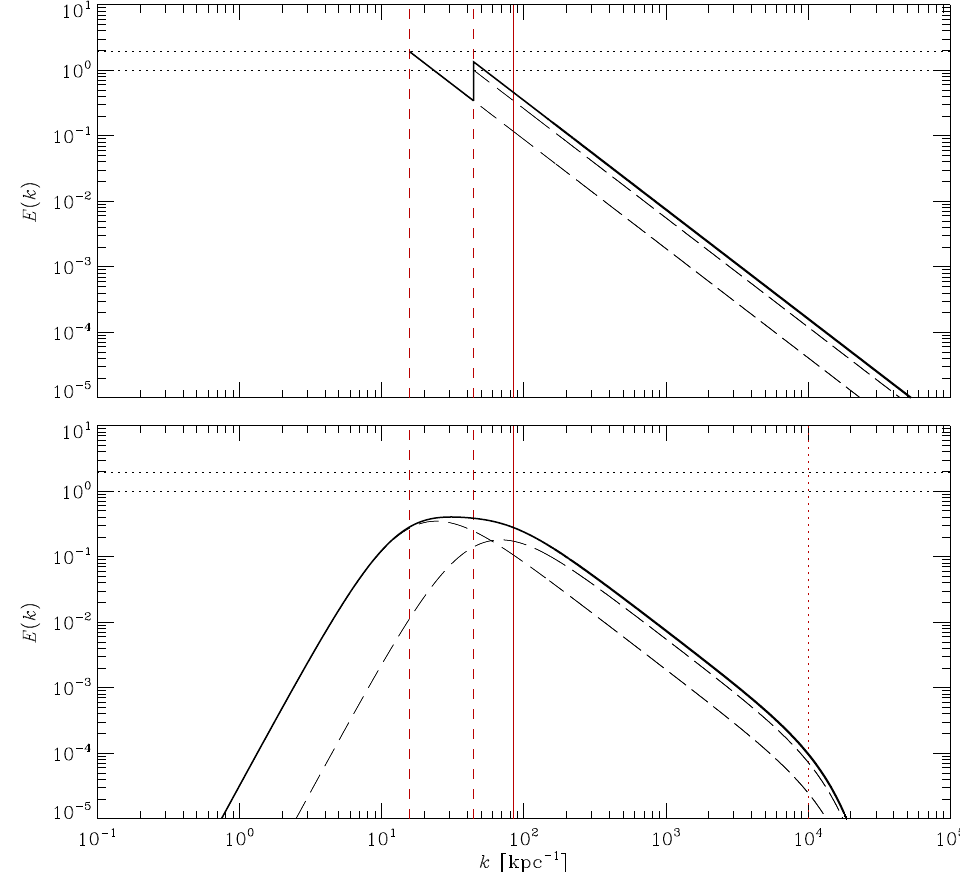
Figure 1. Top: the simple idealized spectrum of Equation (24) normalized to the peak value for isolated SNe, E ( k ) ≡ (cid:101) E ( k ) / (cid:101) E SN . Bottom: the modified von Karman spectrum of Equation (30), with dissipation scale chosen as k d = 10 4 kpc − 1 , and represented by a vertical dotted line. Long-dashed curves show individual spectra of isolated SNe and SBs, while the solid curve shows the total spectrum. Fiducial parameter values of Table 1 have been used, along with γ = 5/3. Dotted horizontal lines reference the peaks of the isolated SN and SB spectra, and vertical dashed lines their respective injection scales l SN and l SB . The wavelength corresponding to the correlation scale of turbulence, 2 π / l , with l given by Equation (29) with C = 3/4, is marked by a vertical solid